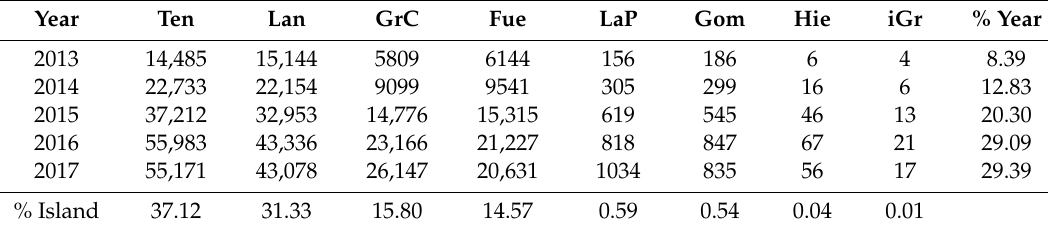
Table 3. Restaurant reviews of the Canary Islands by island and year.